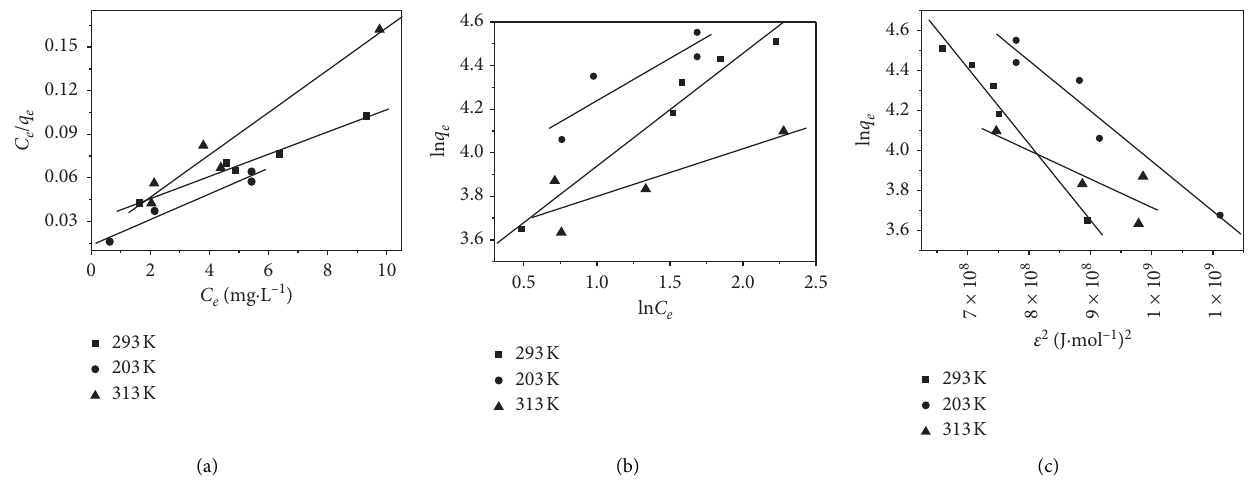
Figure 13: (a) Plots of Langmuir, (b) Freundlich, and (c) Dubinin – Radushkevich isotherms in linear form for the adsorption of phenol red onto AlCB at different temperatures.